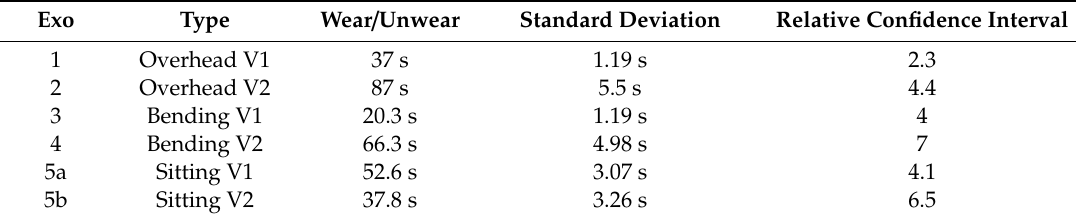
Table 2. Summary of exoskeletons wear / unwear time measurement [4].